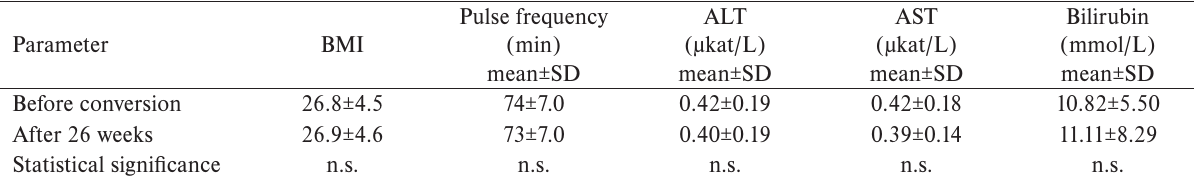
Table 3. selected clinical and biochemical parameters before and after conversion. parameter Before